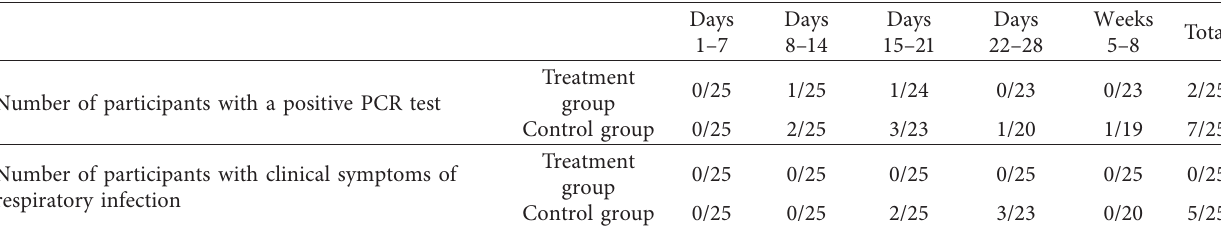
Table 3: Timeline of positive SARS-CoV-2 tests in both groups.